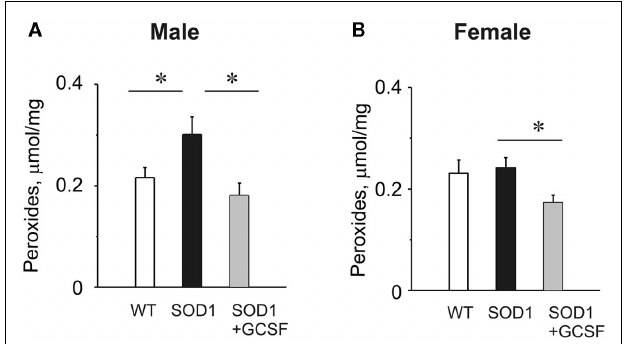
FIGURE 7 |The level of endogenous peroxides inWT, G93A-SOD1 mice, and the antioxidant effect of GCSF. (A,B) Histograms showing the level of peroxides evaluated by FOX1 assay in spinal cord preparations obtained from male (A) or female (B) WT, G93A-SOD1, and GCSF-treated G93A-SOD1 mice. * = P <